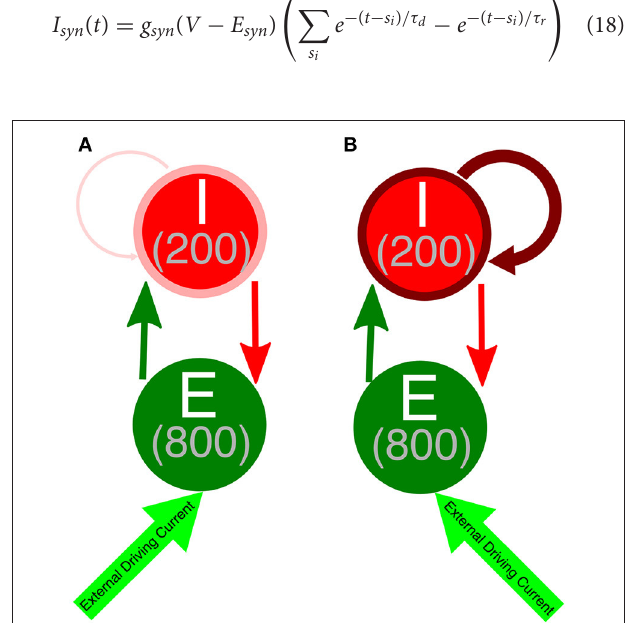
FIGURE 1 | Network diagram of E-I networks. (A) Connectivity in an E-I network with a weakly connected inhibitory subnetwork. Thin, light red arrow symbolizes the weak intraconnectivity between inhibitory interneurons. (B) Connectivity in an E-I network with a strongly connected inhibitory subnetwork. Thick, dark red arrow symbolizes the strong intraconnectivity between inhibitory interneurons. In both diagrams, the dark green arrow symbolizes E-I synapses, while the red arrow indicates I-E